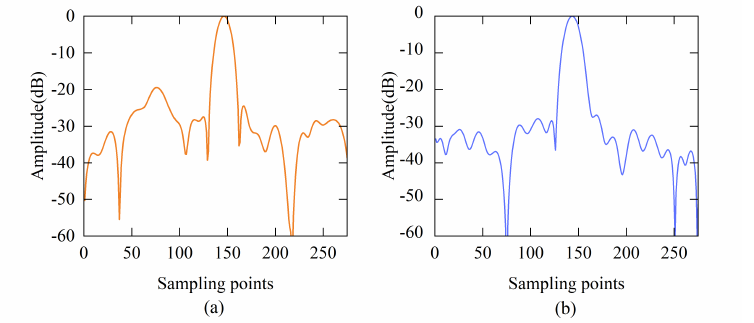
Figure 18. Target analysis of imaging results based on interpolation method. ( a ) Range profile. ( b ) Azimuthal profile.